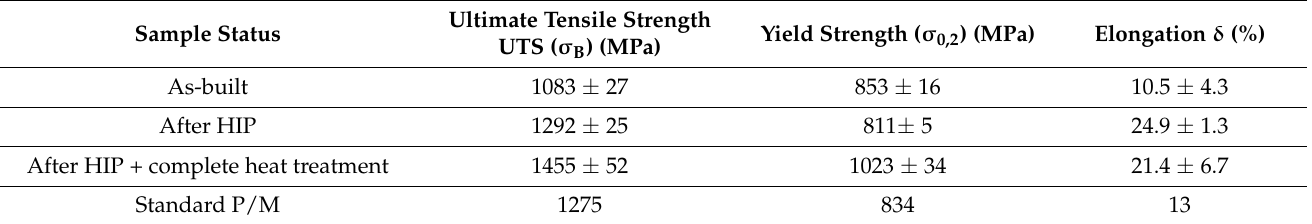
Table 3. Changing the mechanical properties of the Ni-based superalloy EP741NP obtained by the SLM during subsequent HIP and complete heat